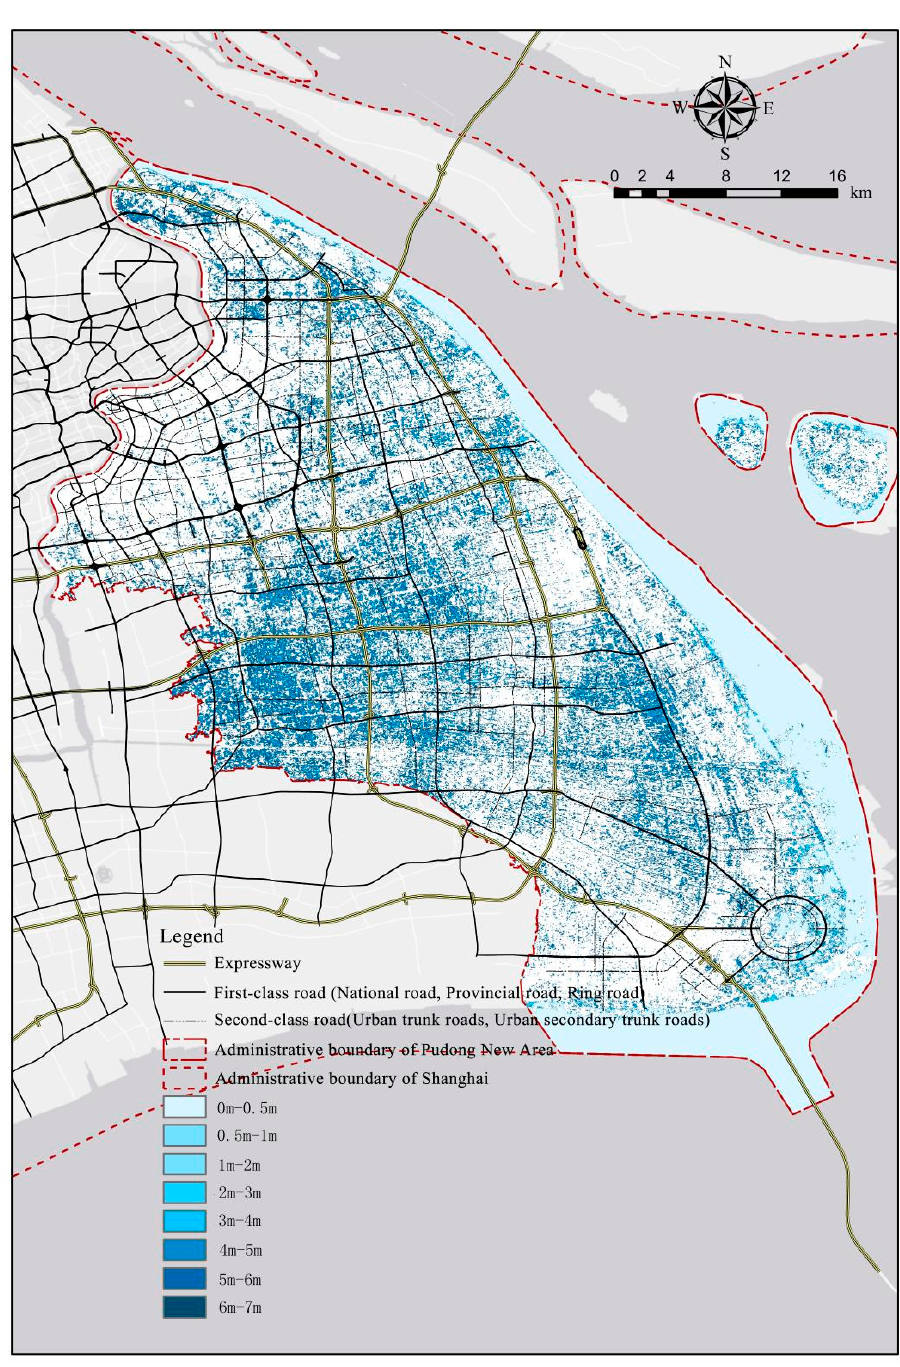
Figure 5. Spatial distribution of the flood inundation depth subjected under different inundation scenarios. (Source: self-drawn by the author).